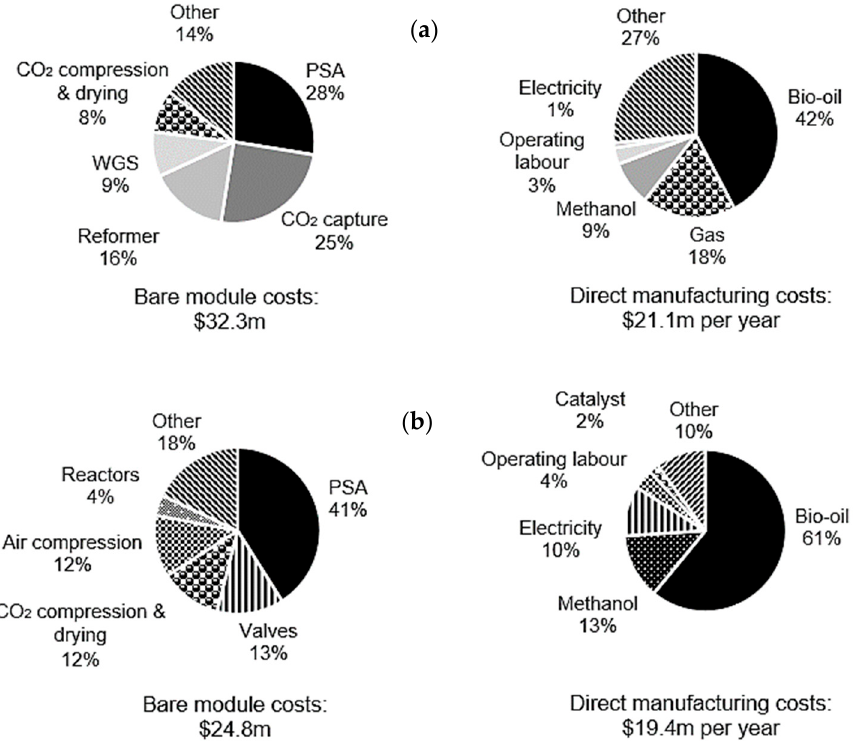
Figure 7. Breakdown of bare module costs and direct manufacturing costs in a 10,000 Nm 3 h − 1 process for ( a ) C-SR-CCS and ( b ) SE-CLSR.